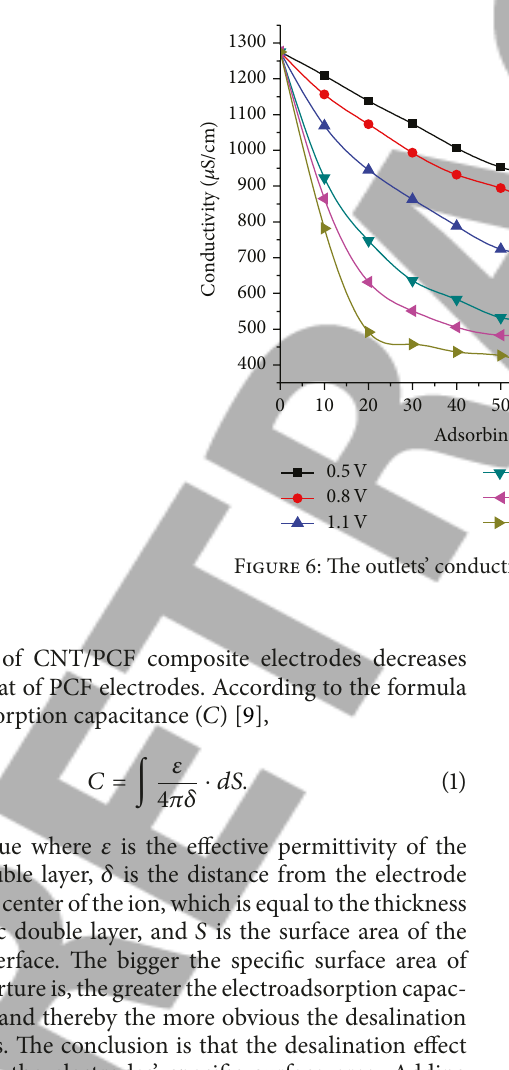
Figure 5: The adsorption time of CNT/PCF composite electrodes and PCF electrodes.